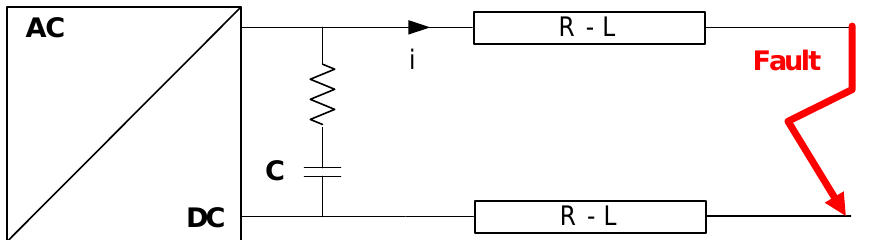
Figure 5. HVDC equivalent network considered for analysis of di/dt HV.